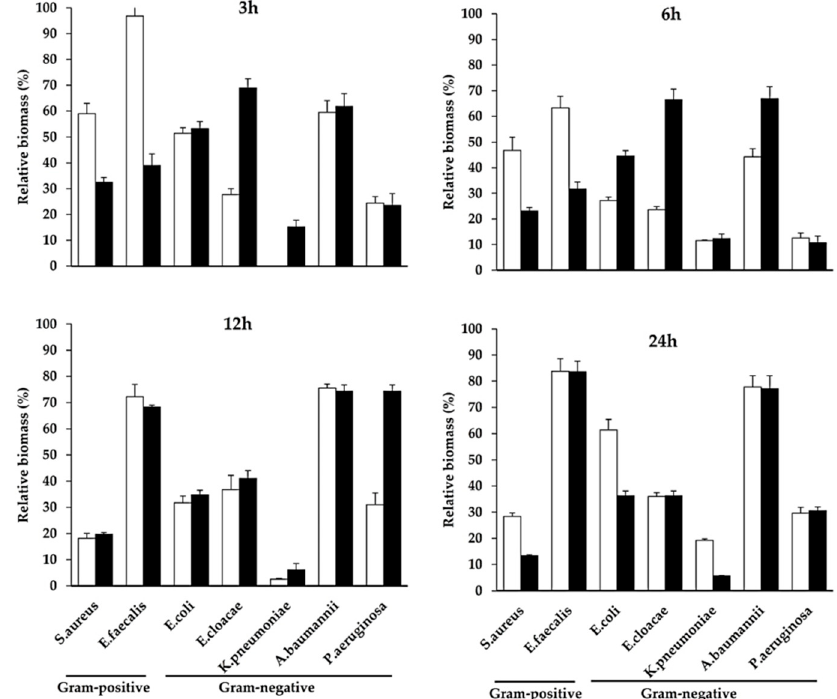
Figure 1. In vitro evaluation of mature biofilm eradication. Remaining biomass on the culture plates was evaluated after 3 h, 6 h, 12 h, and 24 h of in vitro treatment. Values represent the percentage of the mean ± SD of biomass formation, relative to untreated control, in cultures treated with 95% CFEAS (white bars) or 1.5% PHMB (black bars, antiseptic control). Differences in the eradication of biofilm were evaluated with a nonparametric analysis of variance (Kruskal–Wallis Test), and differences among microbial cultures were evaluated using Dunn’s or Tukey–Kramer multiple-comparisons tests, according to the normality behavior of the data. All treatments exhibited statistically significant differences compared to the corresponding untreated control ( p ≤ 0.05), except for E. faecalis CFEAS treated cultures at 3 h.